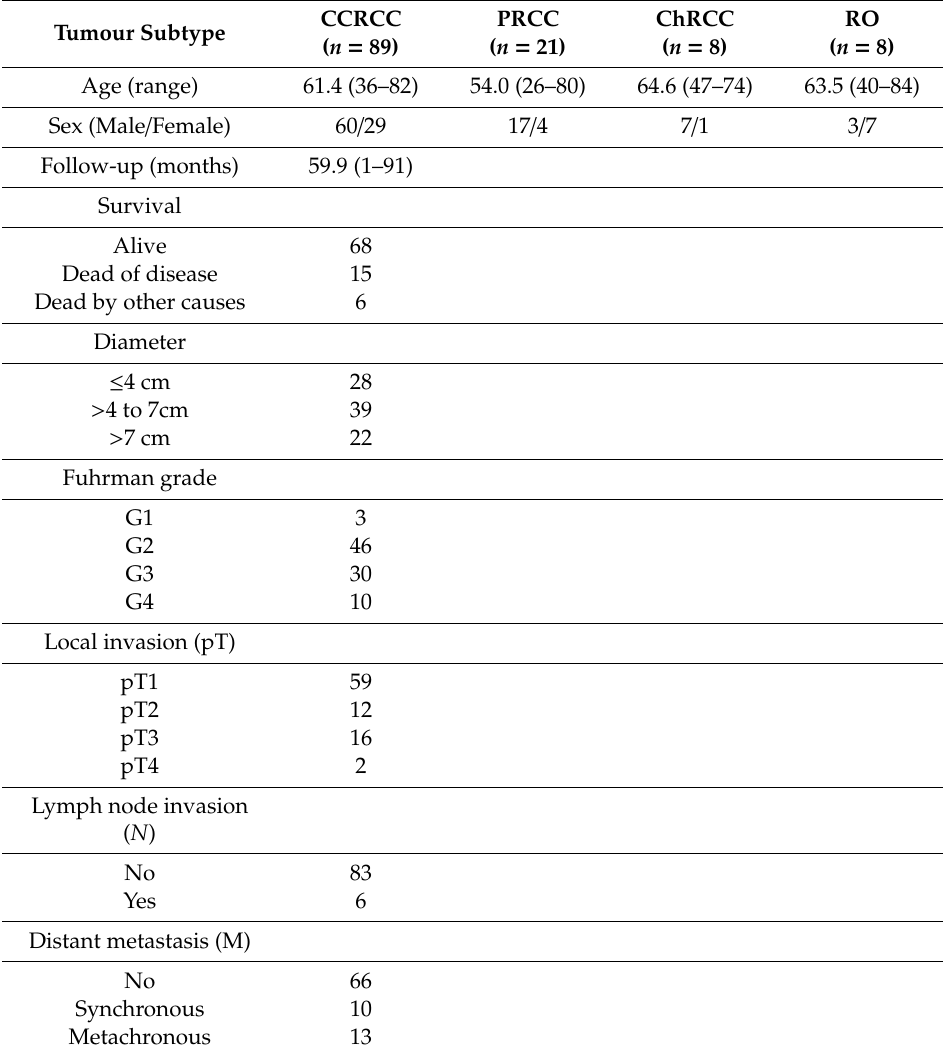
Table 3. Clinical and pathological parameters of CCRCC patients, and gender and age of patients with PRCC, ChRCC and